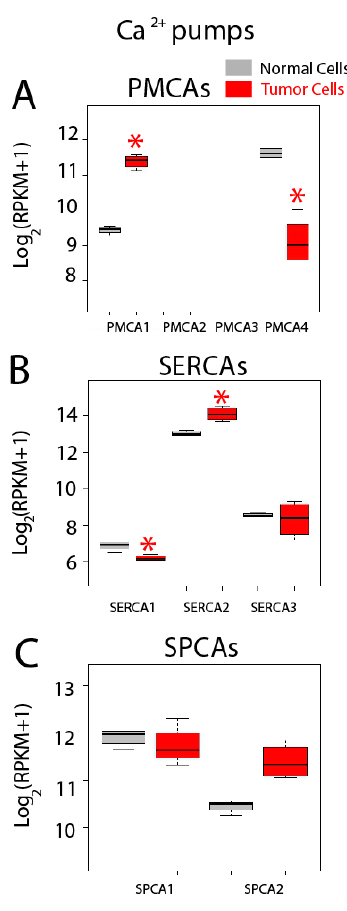
Figure 11. Expression of Ca 2+ pumps in normal and colon cancer cells. Expression levels of plasma membrane Ca 2+ ATPases (PMCAs) ( A ), sarcoplasmic and/or endoplasmic reticulum Ca 2+ ATPases (SERCAs) ( B ) and secretory pathway Ca 2+ ATPases (SPCAs) ( C ) in normal colonic cells (grey bars) and colon cancer cells (red bars). *p statistically significant by three independent methods.